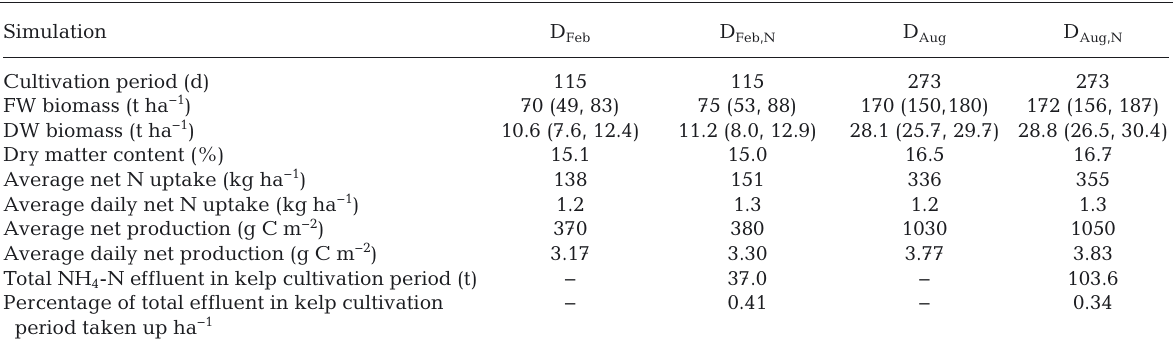
Cultivation period (d)